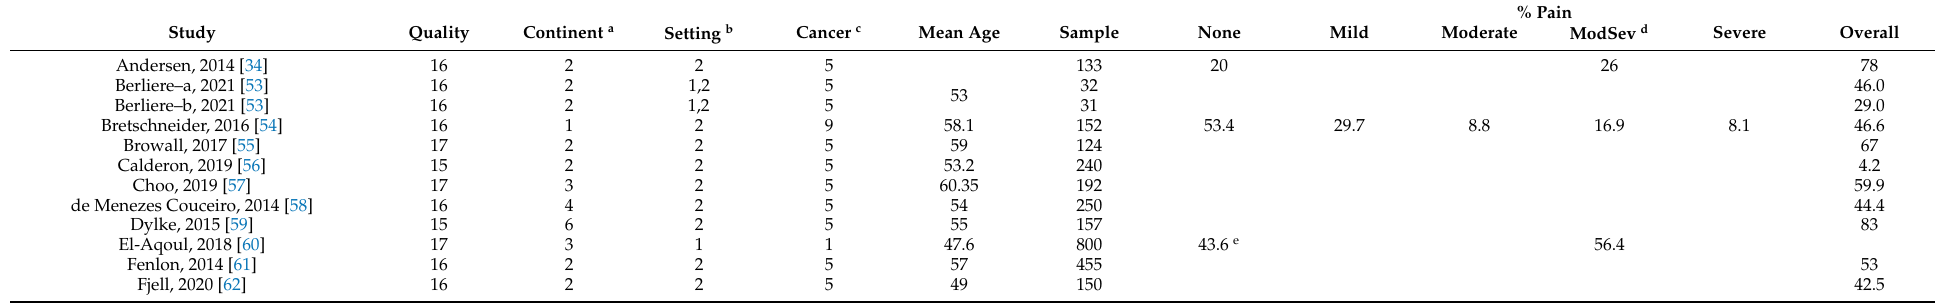
Table 3. Pain prevalence in patients with curative treatment (Group 2) ( n =